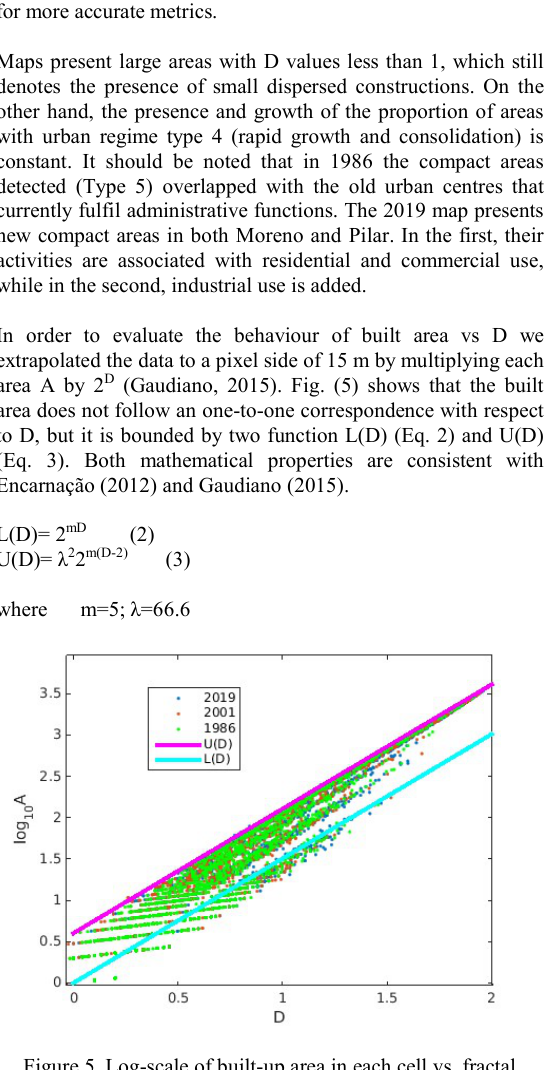
Figure 5. Log-scale of built-up area in each cell vs. fractal dimension (D). Note there is not an one-to-one correspondence: the built up area range is bounded by L(D) and U(D)